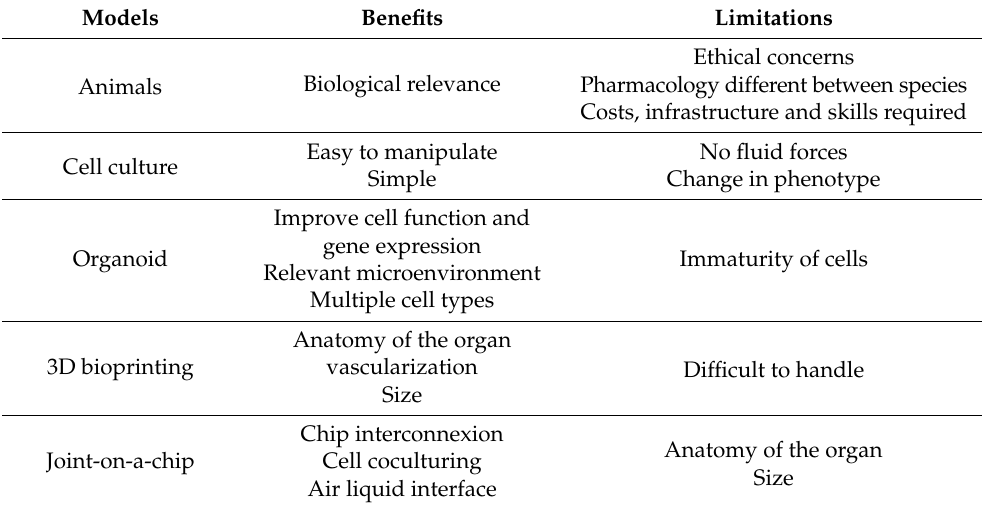
Table 1. Pros and cons of the different joint